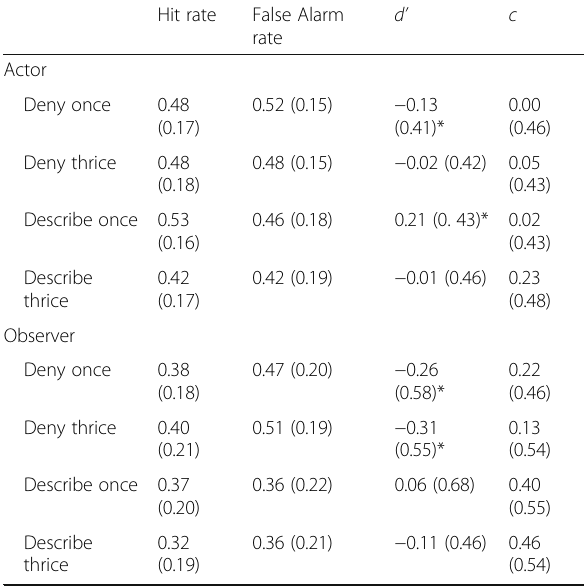
Table 2 Results in experiment